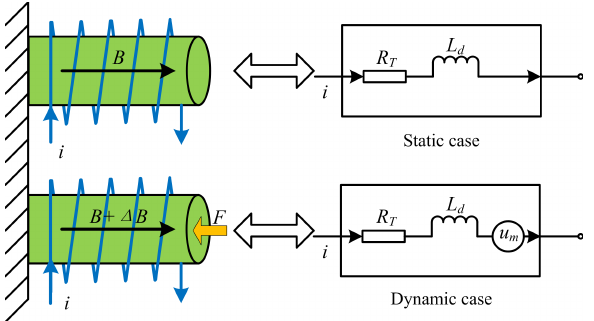
Figure 2. Equivalent impedance of GMA in the static case and the dynamic